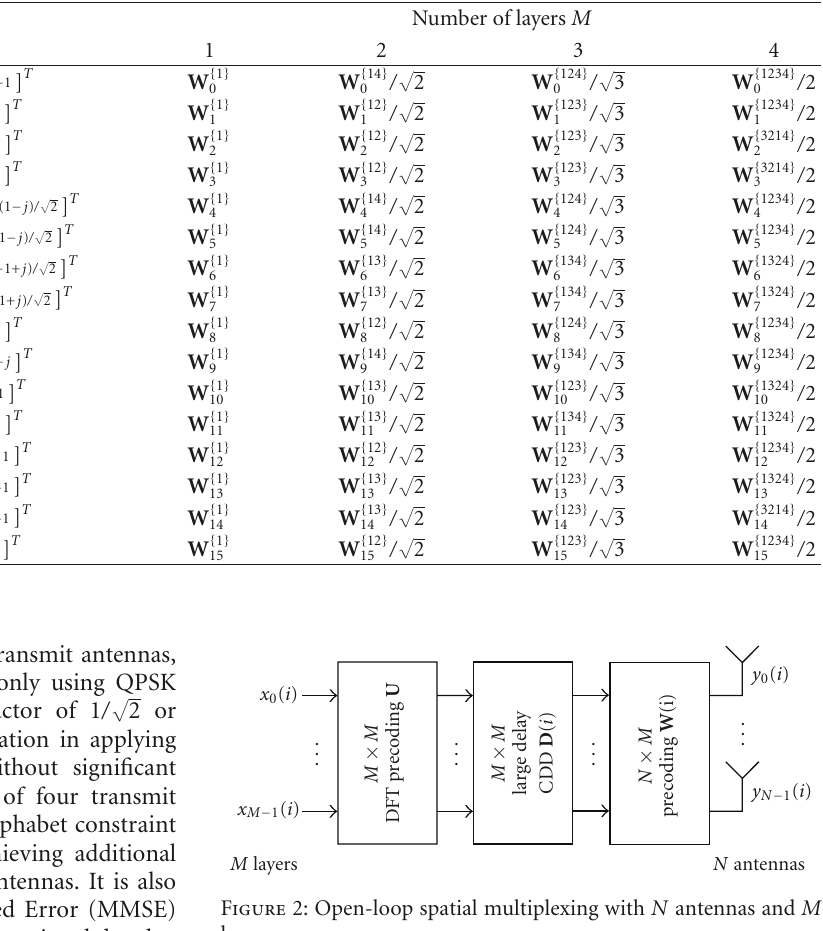
Table 2: Precoding codebook for transmission on four antennas.